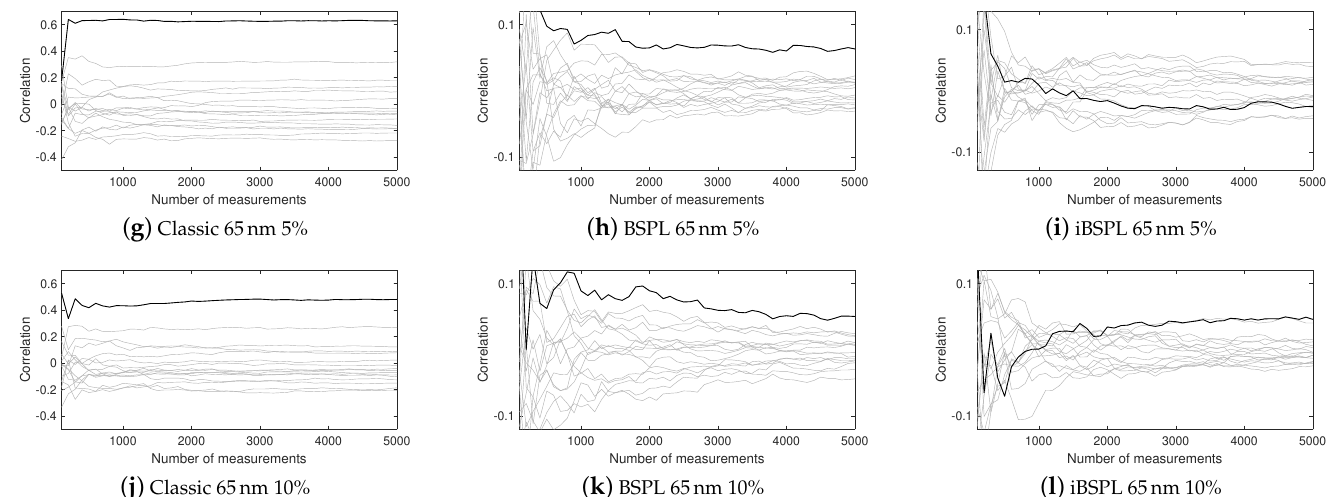
Figure 12. Average of 500 MCDPA attacks using 5000 simulations of noisy SBox leakage currents for random inputs modeling different levels of intra-die process variations (65nm).